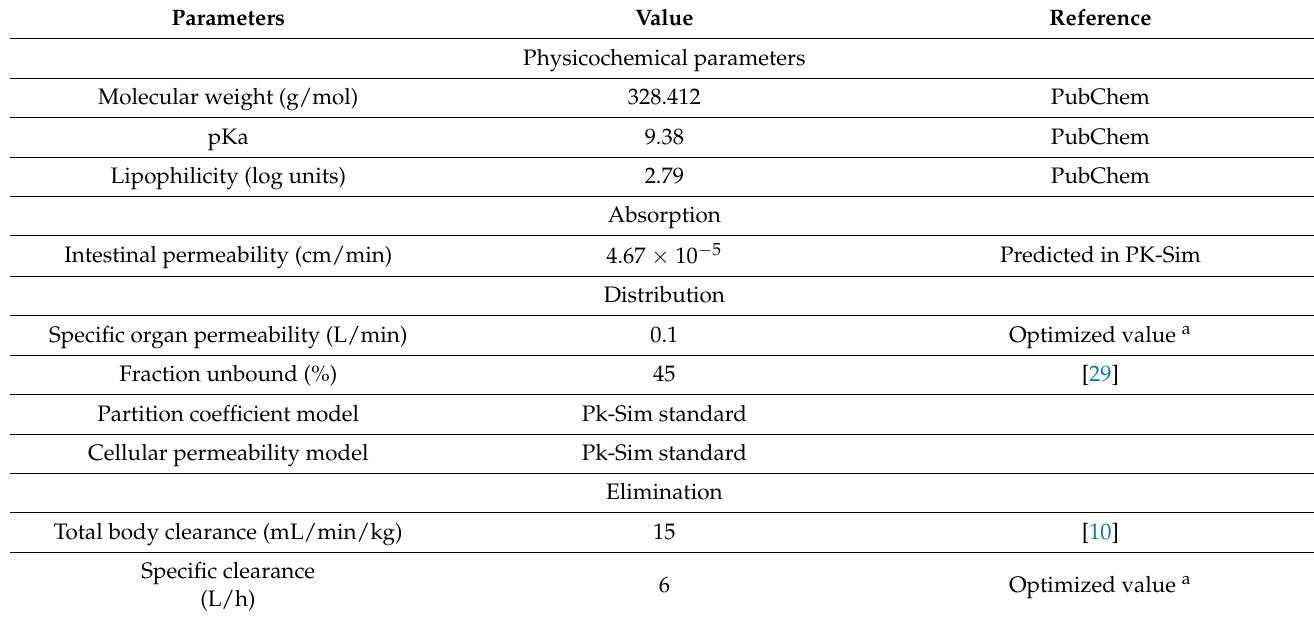
Table 2. Input parameters used in PBPK